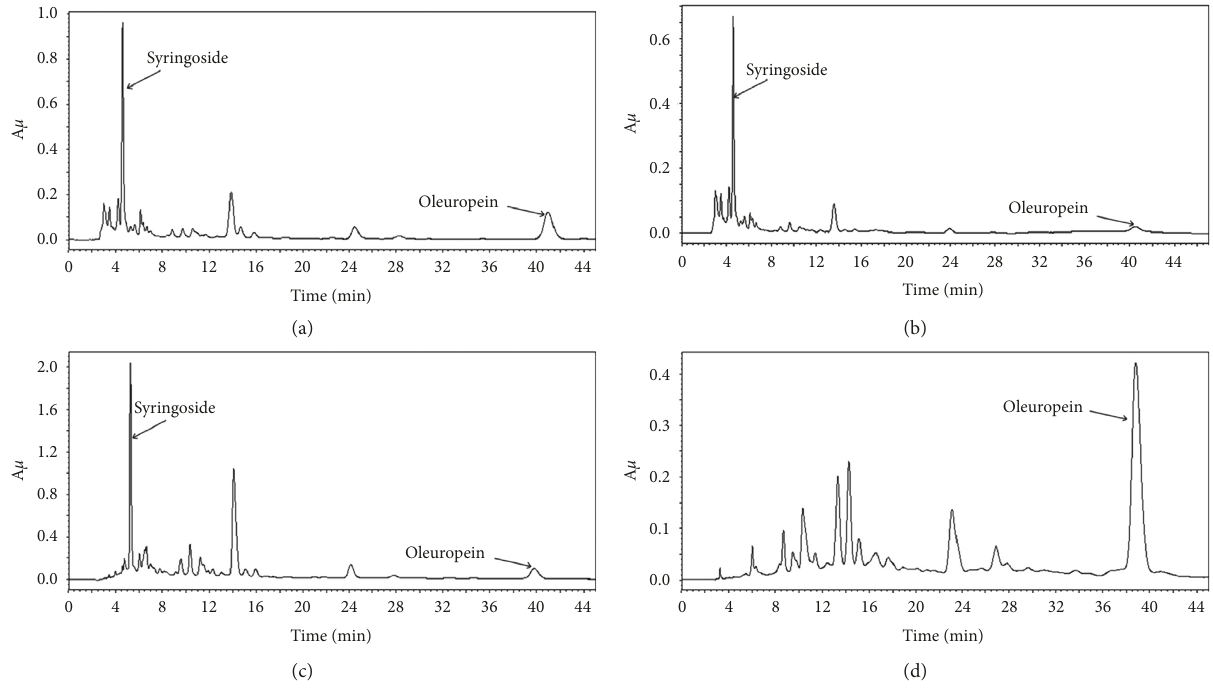
Figure 8: Chromatograms of the sample solution before and after treatment with the HPD-100B resin; (a) before treatment; (b) the effluent from the resin column (15BV–60 BV); (c) 20% ethanol elution; (d) 40% ethanol